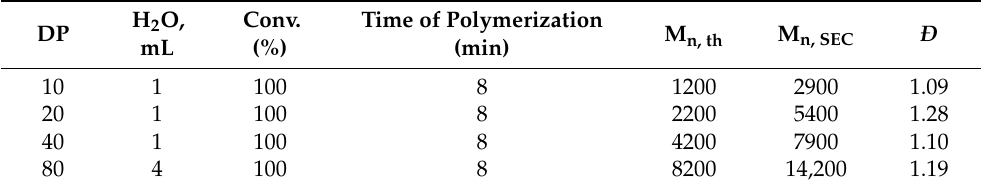
Table 1. Summary of characteristics of different DPs of dimethylacrylamide (DMA) by Cu(0)- mediated polymerization under various